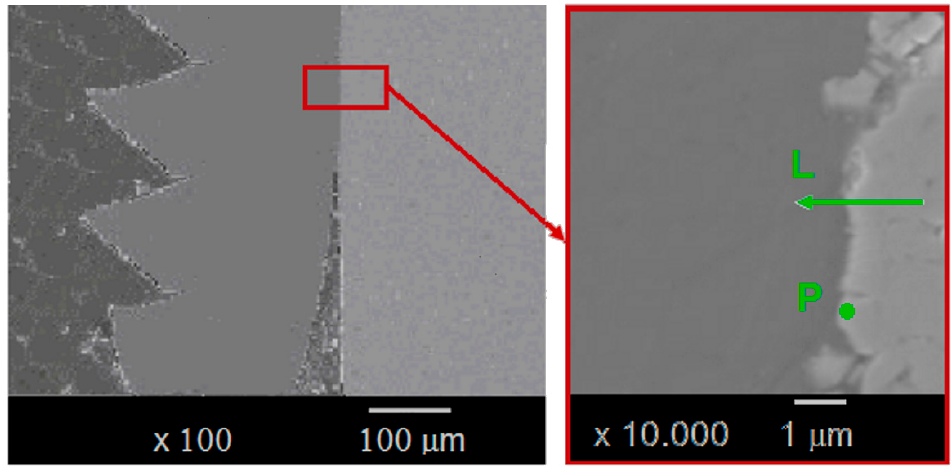
Figure 19. Adhered chip on the drill and zones which have been analized (composition profile along the line L and in-depth profile in point P).